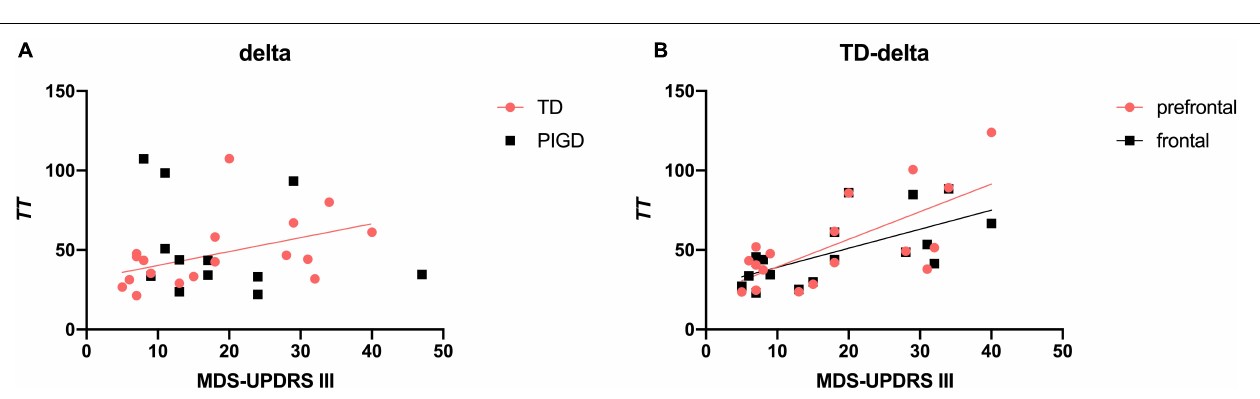
FIGURE 2 | Correlation between TT delta and MDS-UPDRS III scores in patients with PD. TT delta was positively associated with MDS-UPDRS III scores (A) , especially in the prefrontal and frontal regions (B) . A significant correlation ( p < 0.05) is marked in solid red and black lines.